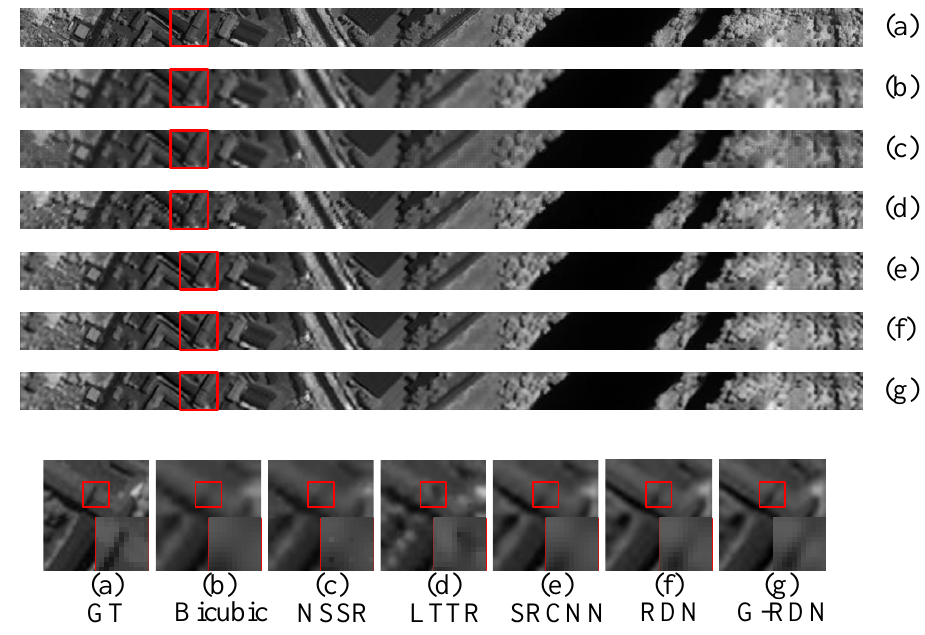
(a) x2 Figure 11. Visual exhibition of the reconstructed Pavia Center at the scaling factor of 4.